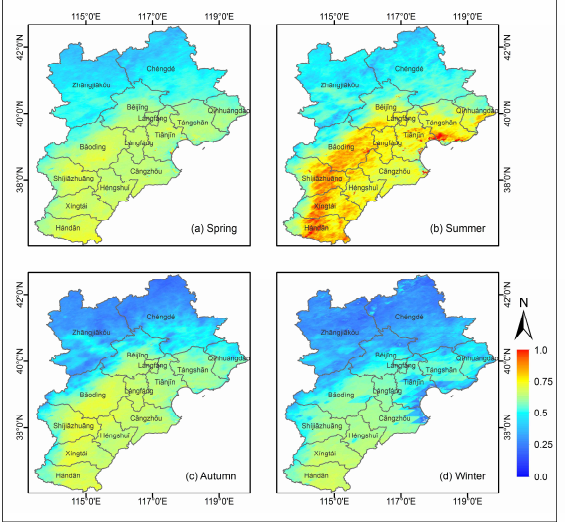
Figure 9. Spatial distribution of AOD seasonal averages in BTH region from 2014 to